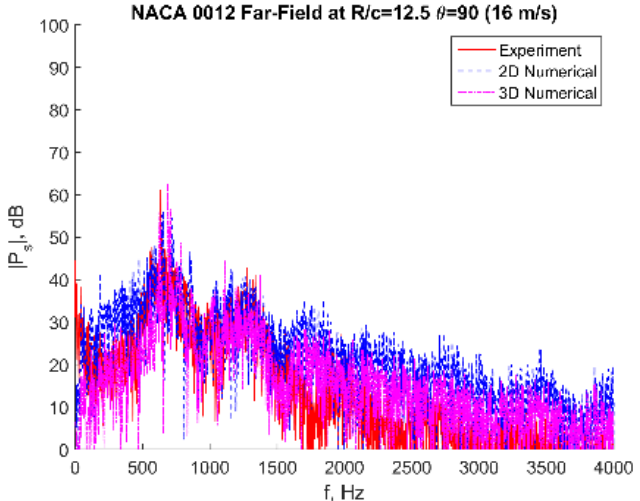
Figure 13. Comparison of 2D (blue) vs. 3D (magenta) vs. measured (red) far-field pressure spectra [18].